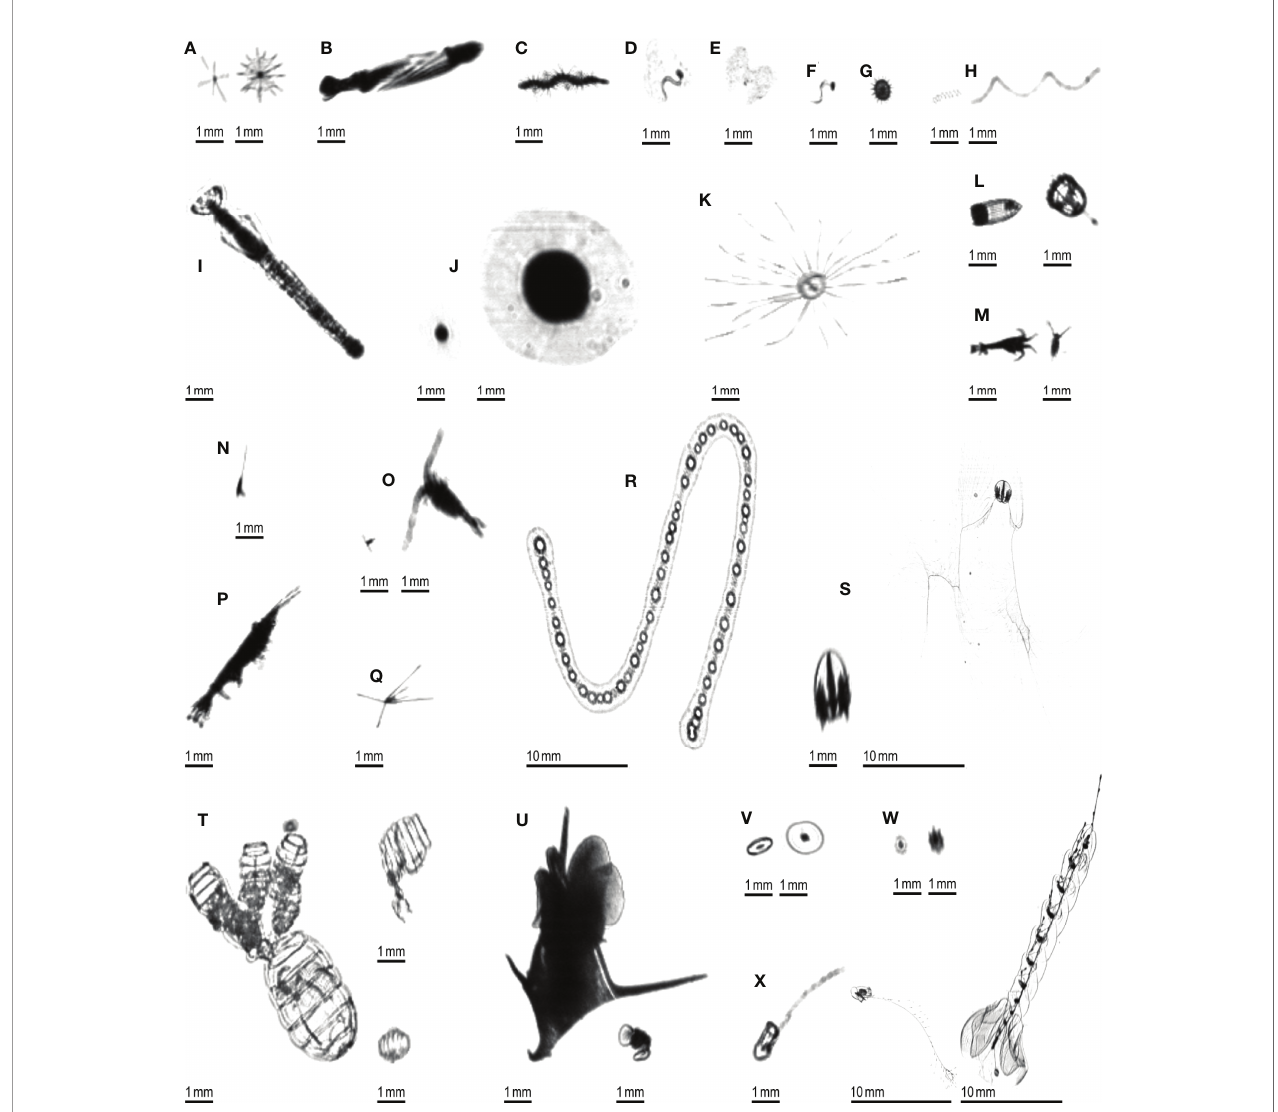
FIGURE 3 | Examples of planktonic organisms imaged by the ISIIS. (A) Acantharea; (B) Actinopterygii; (C) Annelida; (D) Appendicularia; (E) Appendicularia (house only); (F) Appendicularia (body only); (G) Aulacanthidae; (H) Bacillariophyceae; (I) Chaetognatha; (J) solitary Collodaria; (K) Hydrozoa; (L) Cnidaria (other than Hydrozoa); (M) Crustacea (other than Harpacticoida, Copepoda and Eumalacostraca); (N) Harpacticoida; (O) Copepoda (other than Harpacticoida); (P) Eumalacostraca; (Q) Echinodermata (pluteus larva); (R) colonial Collodaria; (S) Ctenophora; (T) Doliolida; (U) Mollusca; (V) Pyrocystis; (W) Rhizaria (other than Acantharea; Aulacanthidae and Collodaria); (X)